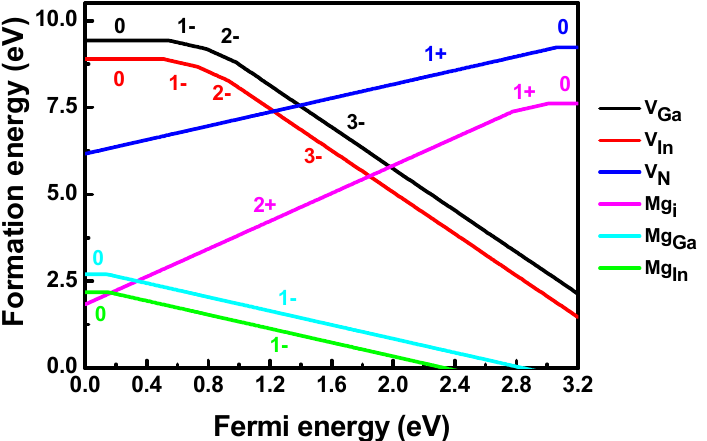
Figure 6. Calculated formation energies of Mg and dominant intrinsic defects as functions of Fermi energy in In 4 Ga 44 N 48 at the N-rich limit. Stable charge states of each defect are included.